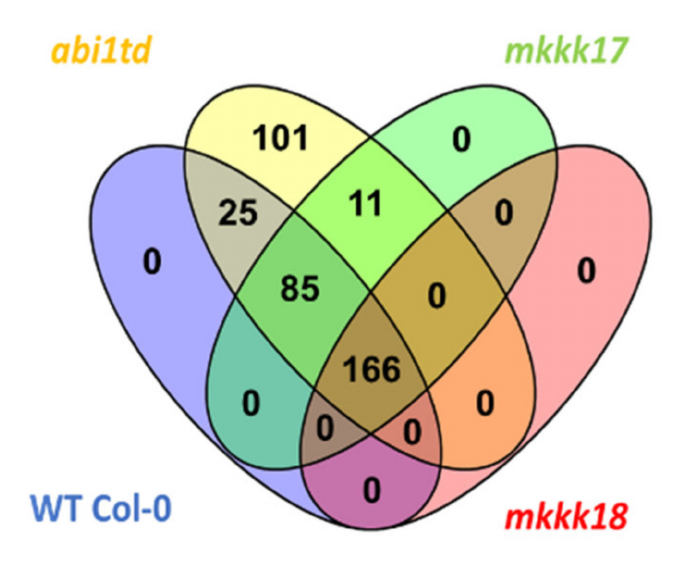
Figure 2. Venn diagram showing the common and specific total small RNAs identified ex- pressed in all samples of ABA-treated vs. mock-treated Arabidopsis WT Col-0, abi1td , mkkk17 , and mkkk18